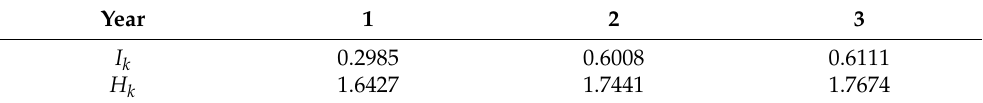
Table 4. The forecast results from I k and H k for the next three years.